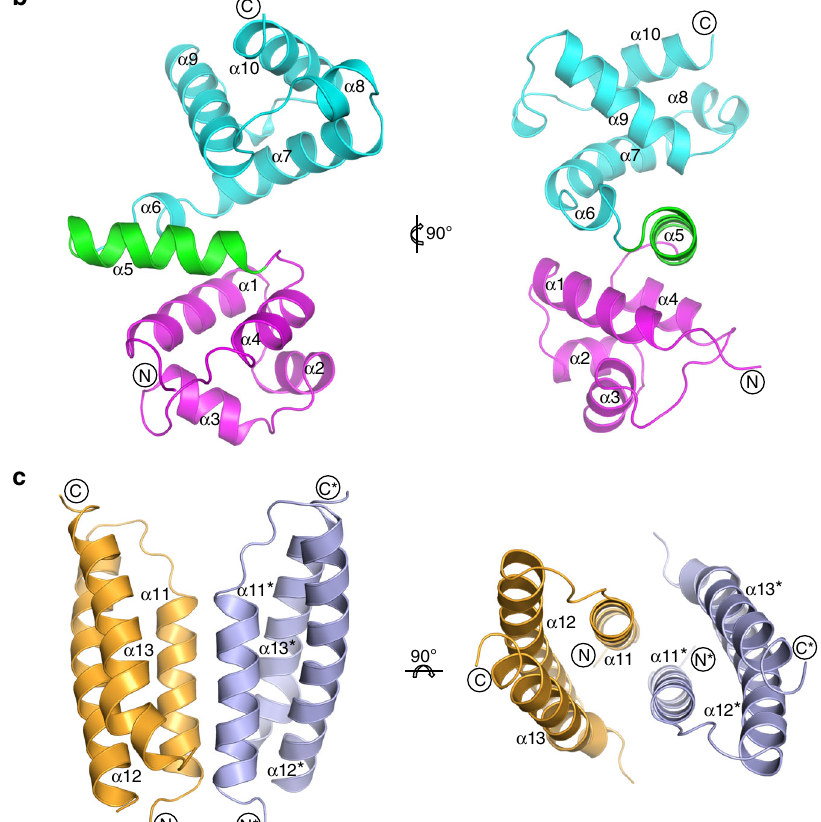
Fig. 1 Structure of SaPIbov1 Stl domains. a Sequence of SaPIbov1 Stl. The sequence of SaPIbov1 Stl is divided as BovI-Stl N-ter and BovI-Stl C-ter corresponding to the fragments used to solve the crystal structures. Structural elements are shown above the sequence coloured as b and c . The latch observed in the BovI-Stl C-ter structure in complex with ϕ O11 Dut is indicated in red. b Cartoon representation of SaPIbov1 Stl N-ter . Two orthogonal views of the BovI-Stl N-ter structure are shown and the secondary structural elements are numbered and labelled in order from the N to C terminus. The HTH domain is coloured in magenta and the middle domain in cyan, with the connecting α 5 helix in green. c Structure of SaPIbov1 Stl C-ter . Cartoon representation of the BovI-Stl C-ter dimer with protomers coloured in blue and orange, respectively. Two orthogonal views are shown and the secondary structural elements are labelled following the numbering of BovI-Stl N-ter (the asterisk indicates elements from the second